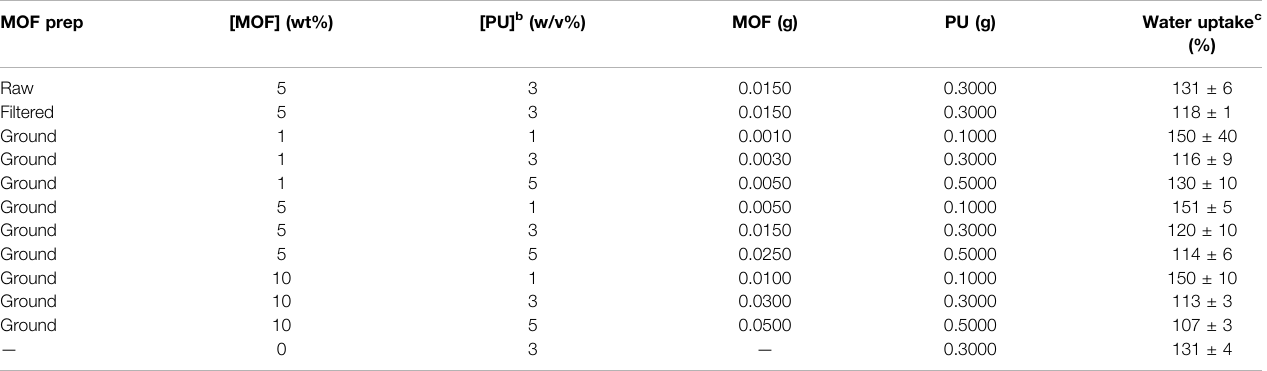
TABLE 1 | MOF composites a